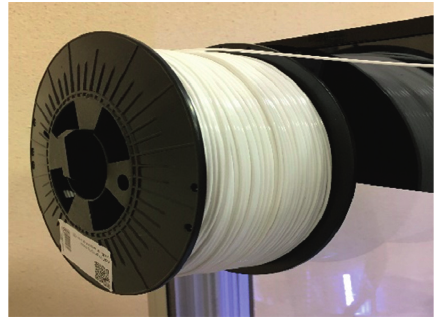
Figure 3: Detail of the printer: wire of PETG used for the 3D printing